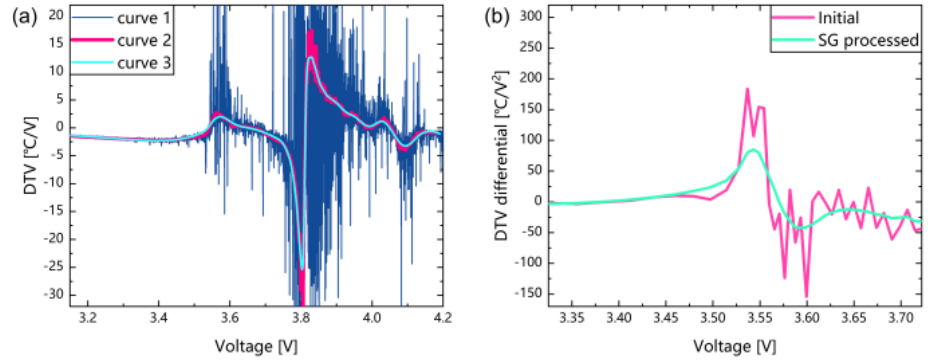
Figure 3. Comparison between original and processed curves. ( a ) DTV curves: Curve 1 is the initial DTV curve, Curve 2 is the DTV curve after filtering temperature, Curve 3 is the DTV curve after filtering temperature and DTV. ( b ) Differential of DTV curves: The red curve is the initial DTV differential; the green curve is the SG processed DTV